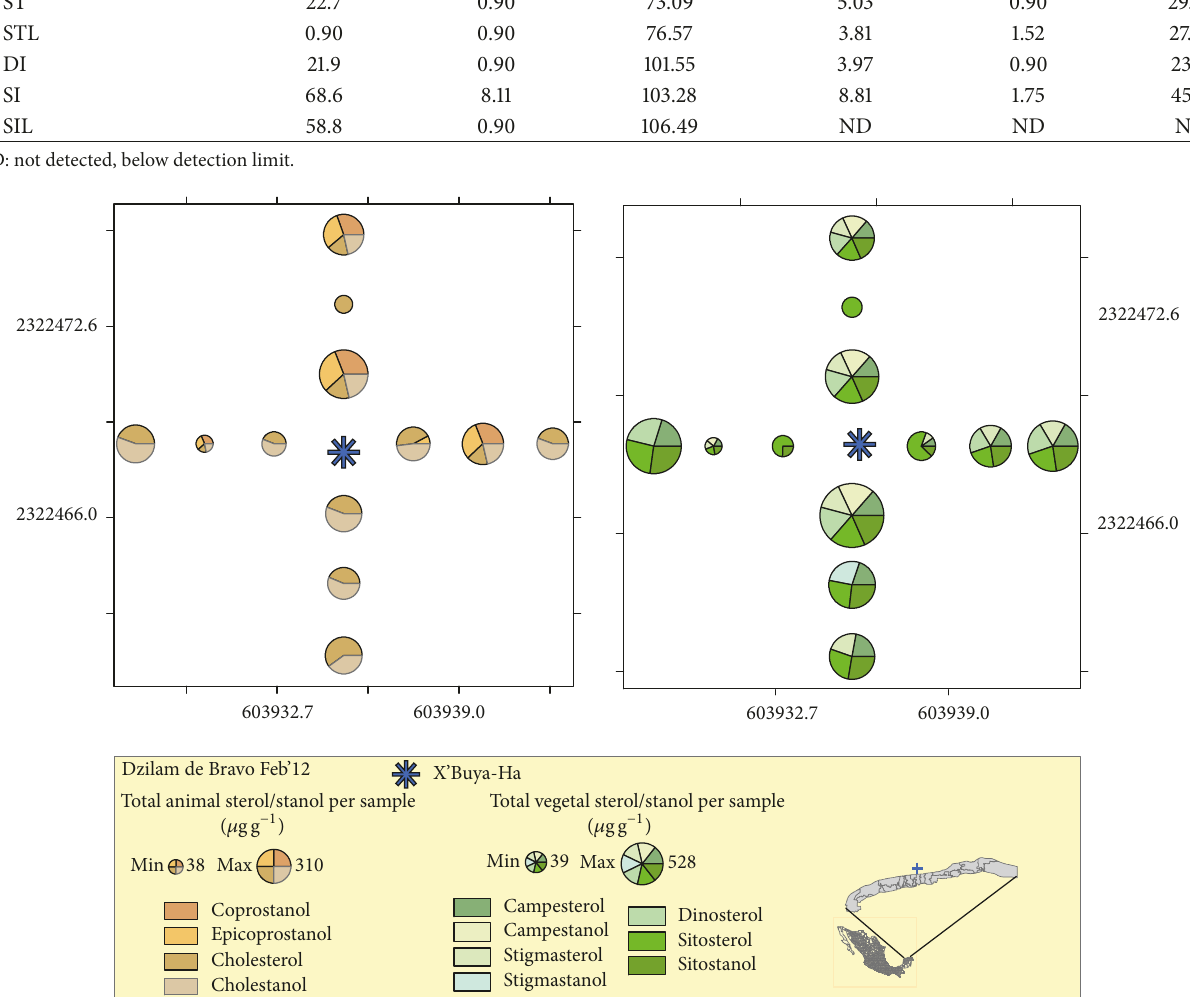
Figure 4: Spatial distribution of sterols and stanols in the sediments surrounding the X’Buya-Ha spring for Nortes season (Feb